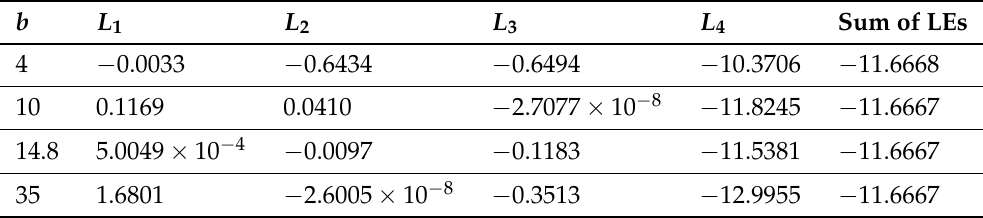
Table 2. The Lyapunov exponents for different b .